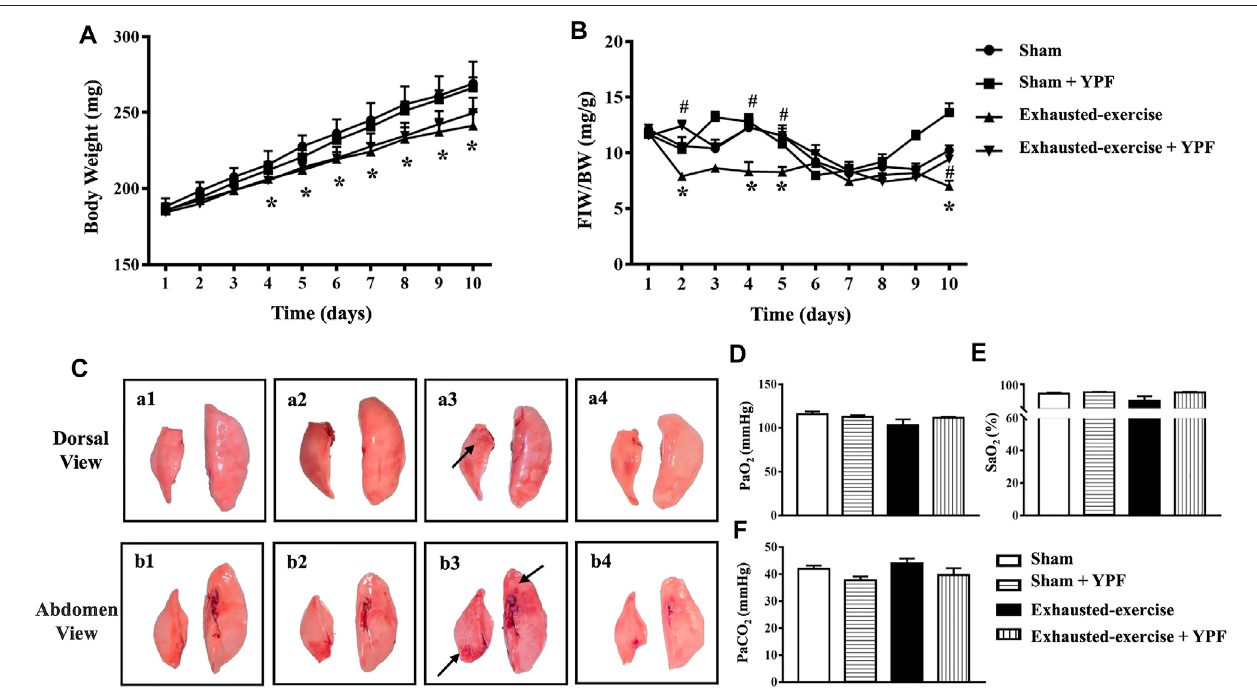
FIGURE1| YPFpreventsthereductioninfood-intakeweight (FIW)/body weight(BW)andimproveschangesinthelung macromorphologyinducedbyexhausted exercise. (A) Alteration of BW with time in four groups. (B) Change in FIW/BW with time in four groups. Values are means ± SEM from eight animals. * p < 0.05 vs. sham; # p < 0.05 vs. exhausted-exercise. (C) Representative images of lung macro morphology in four groups. Arrows: swollen and hemorrhage area. (a1, b1) Sham group; (a2, b2) sham + YPF group; (a3, b3) exhausted-exercise group; and (a4, b4) exhausted-exercise + YPF group. (D) Partial arterial pressure of oxygen. (E) Saturation of arterial blood oxygen. (F) Partial arterial pressure of carbon dioxide. Results are presented as means ± SEM ( n = 6).